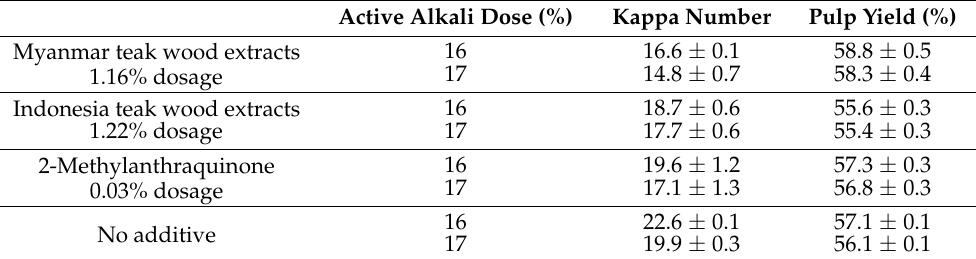
Table 3. Effects of teak wood extracts and 2-methylanthraquinone on kraft